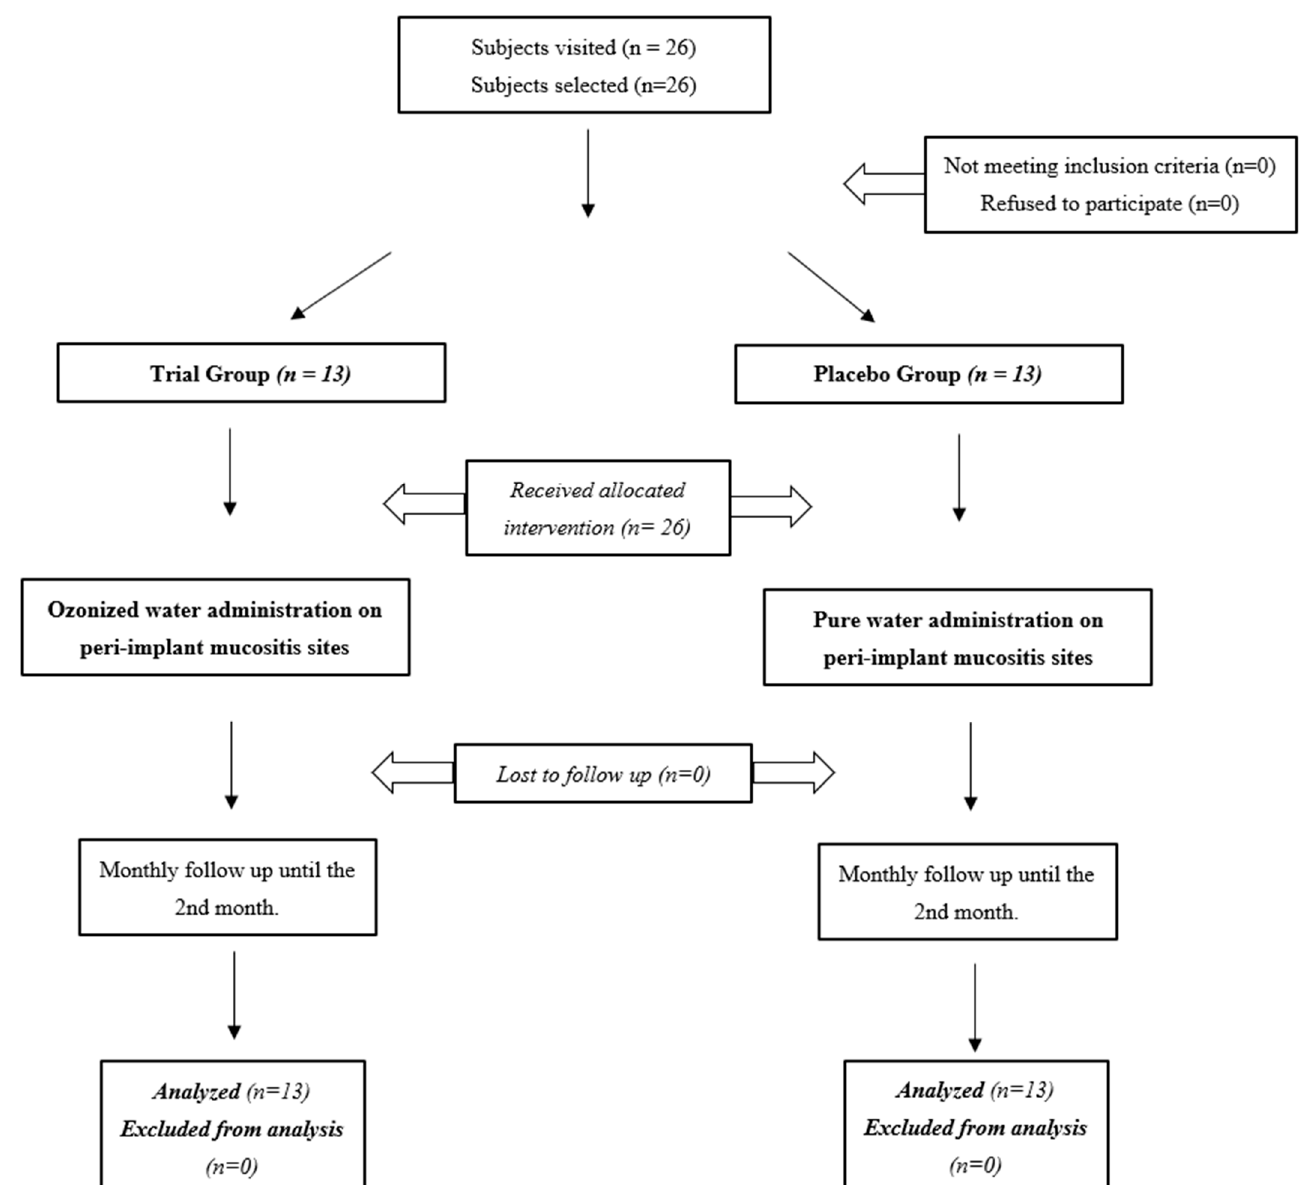
Figure 1. Flow-chart of the study: the figure shows the process of selection, random allocation and follow up of the participants to the study.